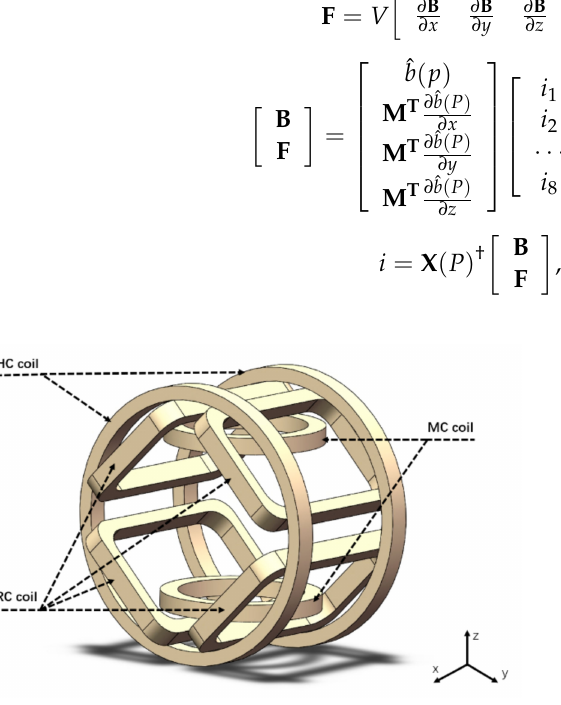
Figure 5. Schematic of the EMA system for the control of the proposed modular capsules. Table 3. Specification of the coils in the EMA